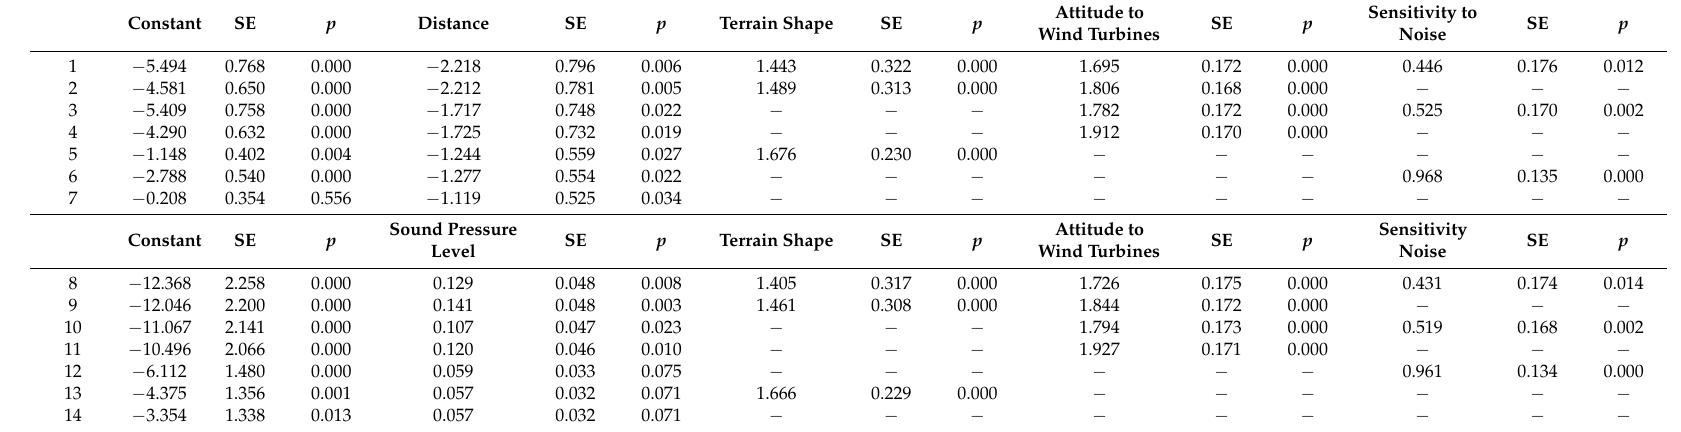
Table 12. Estimated coefficients for various logistic models of high annoyance due to the wind turbine noise